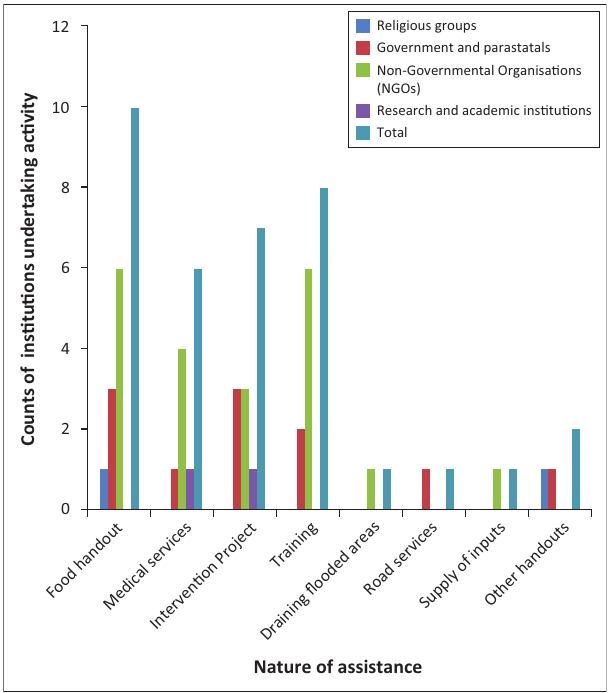
FIGURE 3: Number of institutions and the nature of assistance rendered to the Ntalale community of Gwanda Rural District, Zimbabwe.